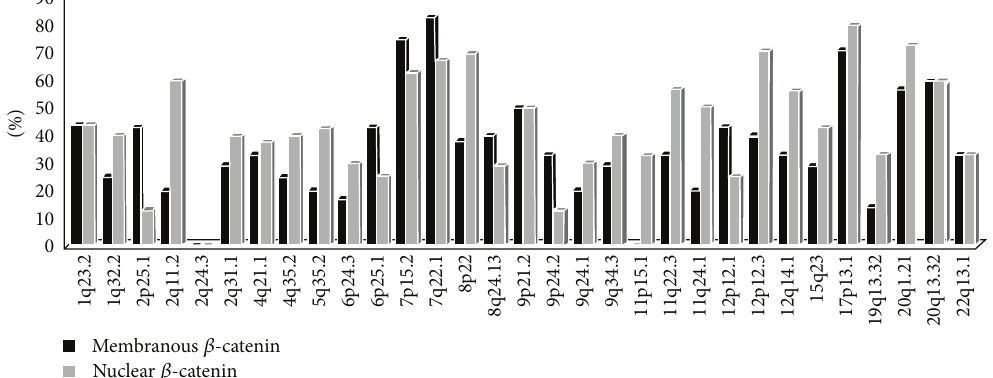
Figure 3: High frequency of LOH at all tested loci in 22 sporadic MSS colorectal cancers (12 with nuclear and 10 with membranous 𝛽 -catenin) indicates significant role of the differentially expressed genes in